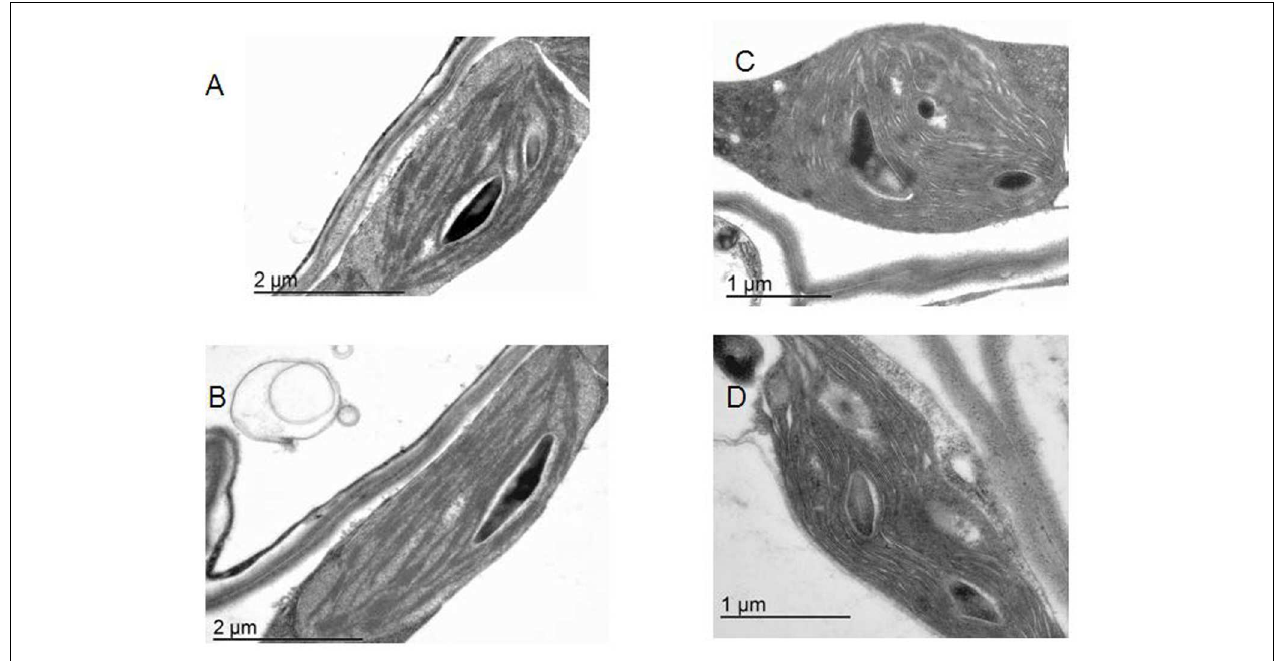
FIGURE 1 | The architecture of plastids. Electron microscopy for WT Arabidopsis line (A,B) and the lines overexpressing TGase (C,D)